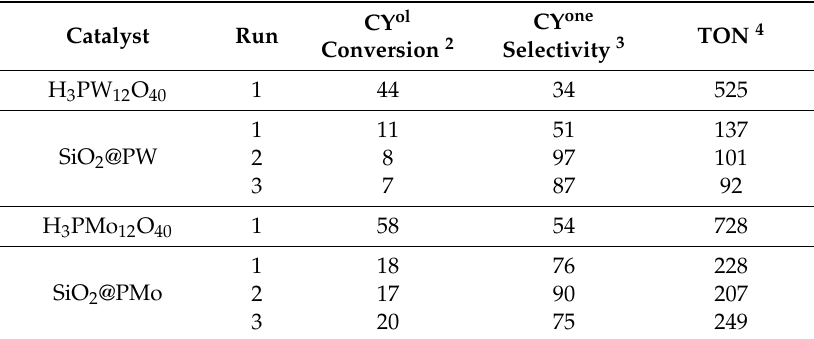
Table 6. Relevant data for the catalyzed oxidation of cyclohexanol after 24 h 1. CY Catalyst Run